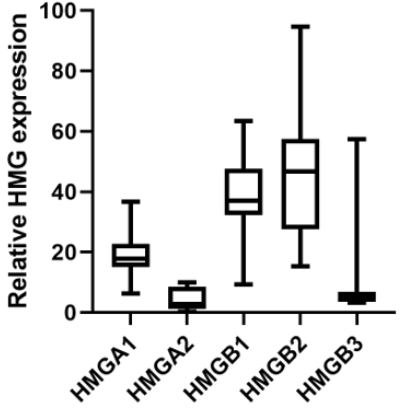
Figure 1. HMGA1, HMGA2, HMGB1, HMGB2 and HMGB3 gene expression in tumors of patients with RMS treated with BOMP/EPI. HMGA1, HMGA2, HMGB1, HMGB2 and HMGB3 gene expression in biopsies of eight patients with RMS treated with BOMP/EPI were analyzed with the EdgeSeq Oncology Biomarker Panel. The total counts of each gene were normalized by GAPDH counts in each sample and the mean value (*1000) for each gene was represented.